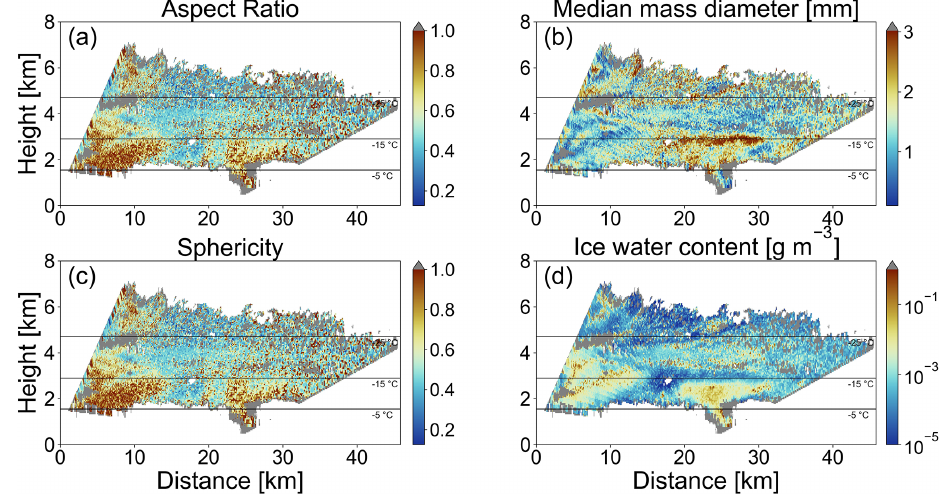
Figure 12. Retrieved (a) AR, (b) D m , (c) S , and (d) IWC for 30 January 2019 at 10:08UTC with ice spheroids assumed to be horizontally aligned prolates and their m(D max ) corresponding to aggregates from Yang et al. (2000). The − 5, − 15, and − 25 ◦ C temperature levels are plotted with black solid lines (source: Deutscher Wetterdienst, data provided by University of Wyoming; http://weather.uwyo.edu/upperair/ sounding.html, last access: 8 April 2022). Areas where ice-masked and noise-filtered measurement values are located are plotted with gray.